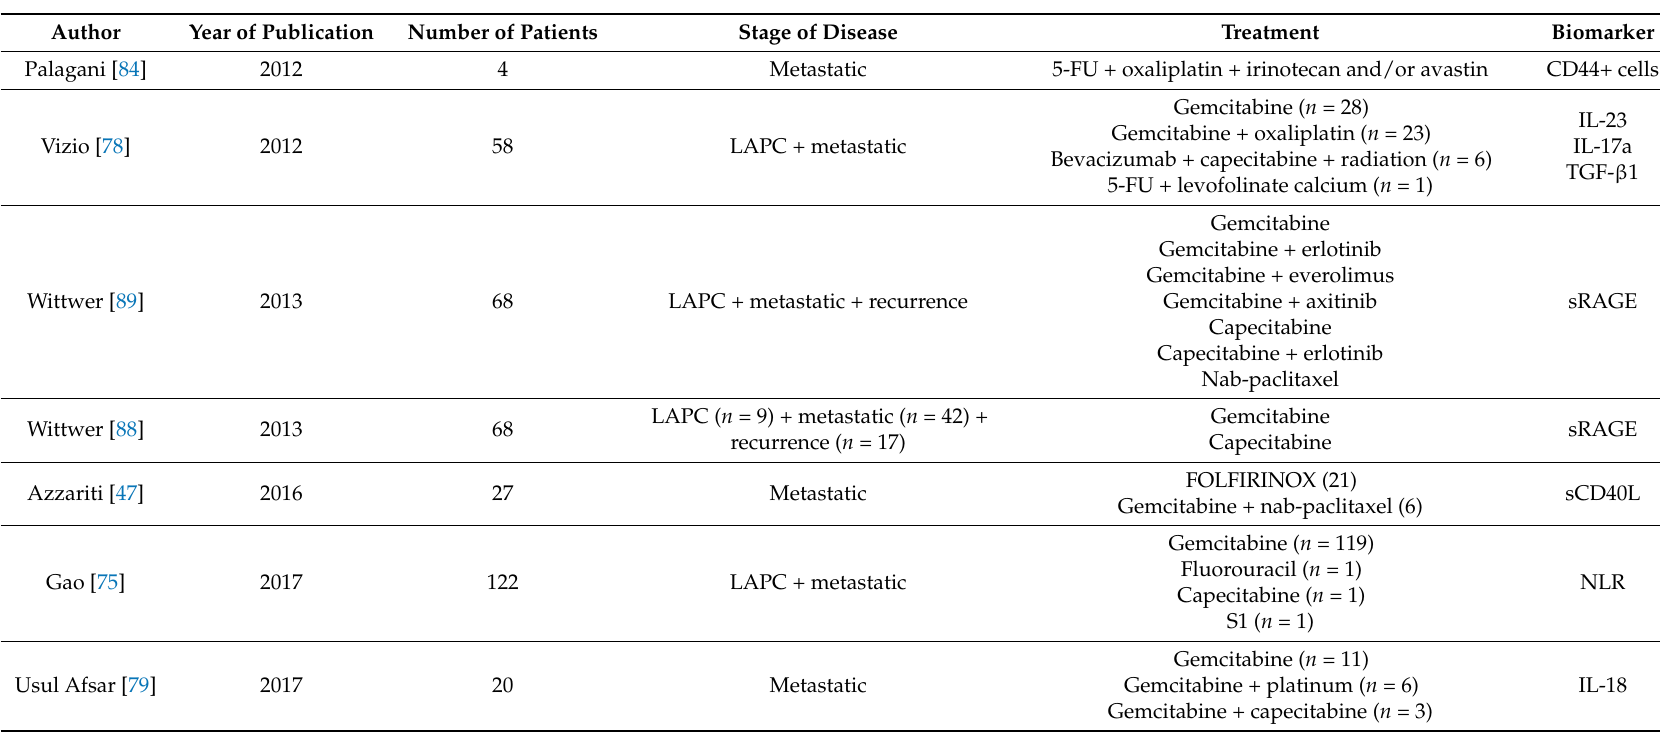
Table 3. Overview of studies including immunologic markers as predictive biomarkers for chemotherapy response in pancreatic cancer